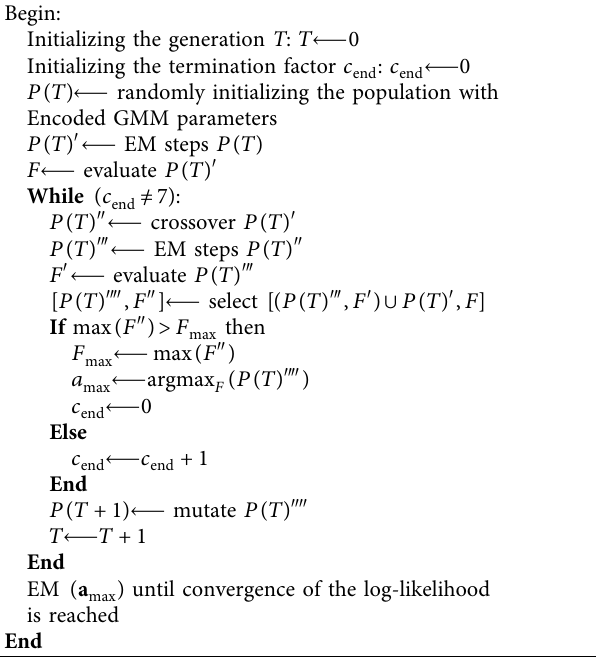
Table 1: Operation procedure of the DE-EM. Begin: Initializing the generation T : T ⟵